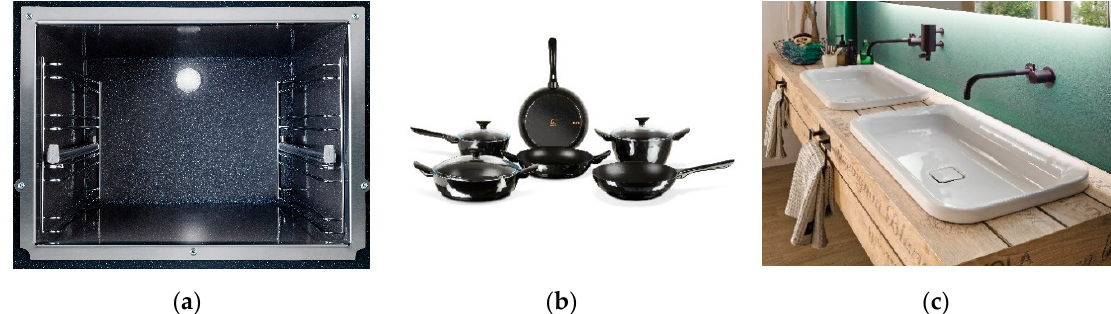
Figure 3. Modern examples of enamel application objects: ( a ) Enameled pyrolytic oven of a modern wood stove, image courtesy of Artecalore, Pergine Valsugana (TN), Italy; ( b ) Enameled cookware set, image courtesy TVS, Fermignano (PU), Italy; ( c ) Enameled bathroom washbasin, image courtesy of Kaldewei Italia, Conegliano (TV), Italy.